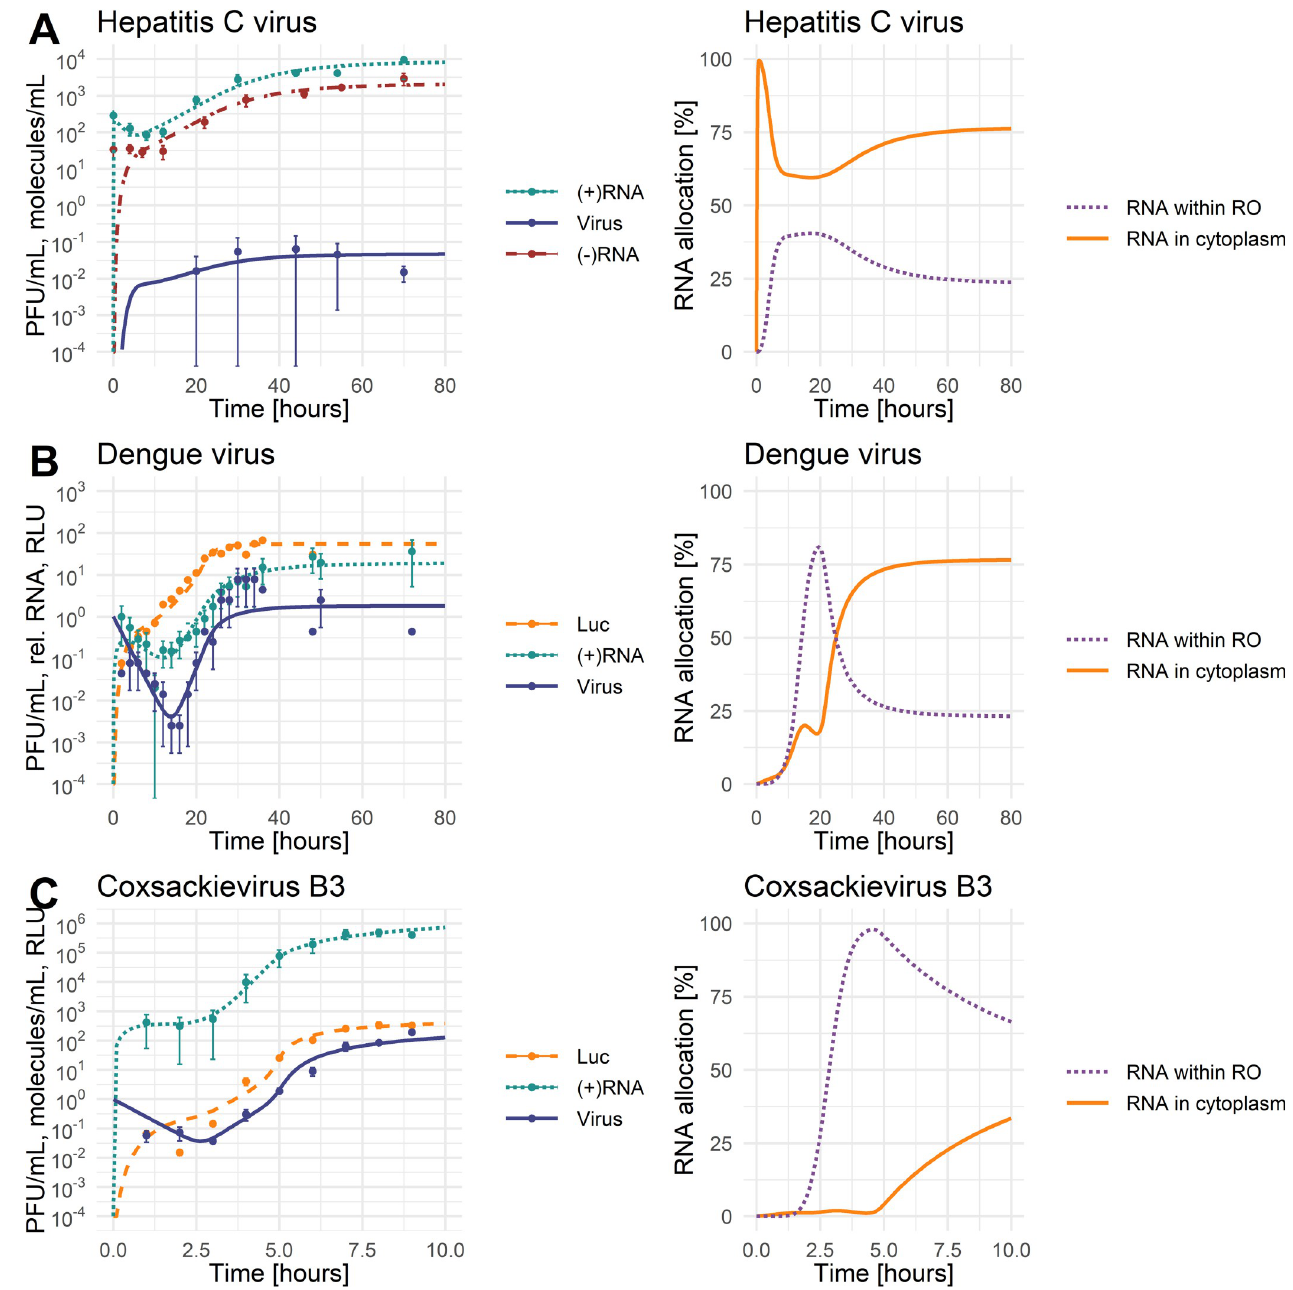
Fig 2. Best fit of the model to the data with standard deviation (left panel) and model prediction of plus-strand RNA allocation between the cytoplasm and replication organelle (RO) (right panel). For parameter values, see Table 2. [LEFT: green: (+)RNA = R tot RNA = R tot ¼ ð R þ R Þ , blue: A) Virus = V tot = V DS IDS M purple: RNA within replication organelle (RO) = RC þ R molecules/mL or relative RNA concentration, luciferase was measured in relative light unit (RLU)].